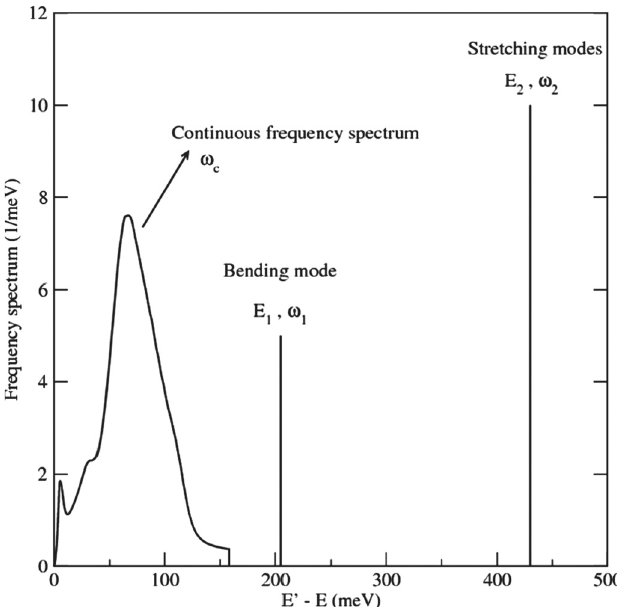
Fig. 1. Continuous frequency spectrum of 1 H in H 2 O and internal vibration modes ( E 1 =205 meV and E 2 = 415meV) of the CAB model as a function of the excitation energy at T = 294K.